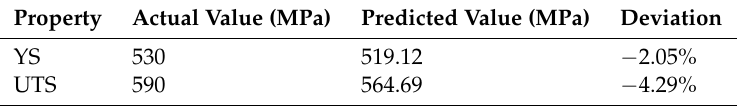
Table 6. Predicted values of the YS and UTS for Al-7010 using the ANN.